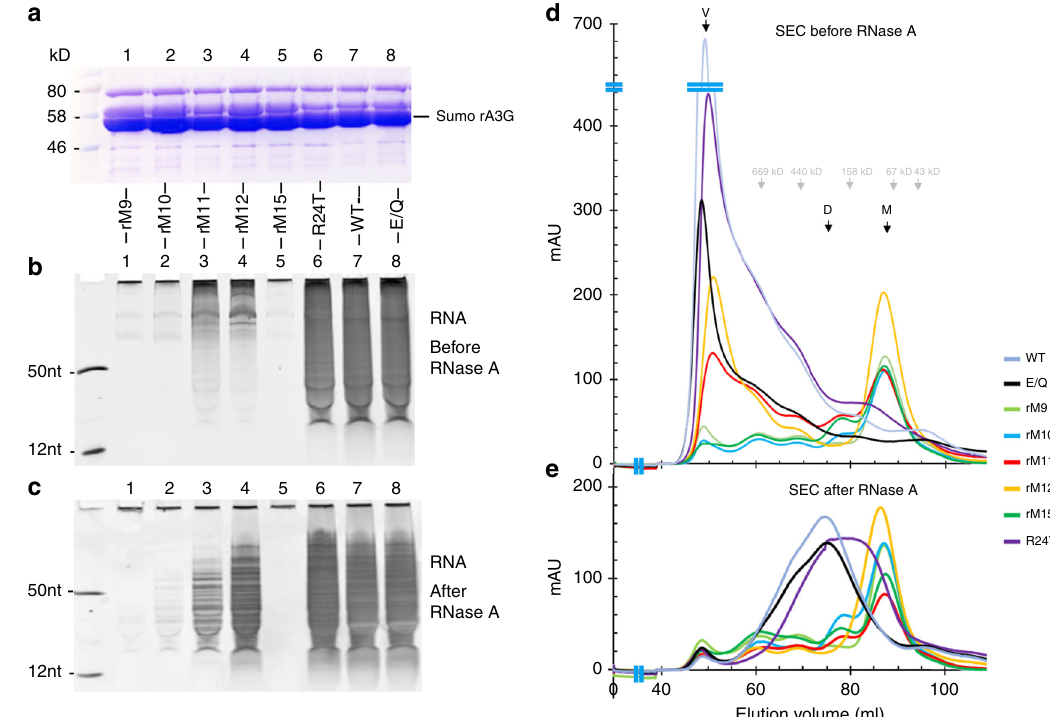
Fig. 3 Probing dimerization and RNA association by targeted mutations of full-length rA3G. a – c The SDS-PAGE protein gel analysis of the His 6 -sumo- rA3G WT and various mutants after nickel af fi nity column puri fi cation ( a ), and 20% denaturing urea polyacrylamide gel analysis of RNAs associated with the proteins without RNase A treatment during puri fi cation ( b ) or with RNase A treatment during puri fi cation ( c ) (see methods for details). d , e Superdex- 200 size exclusion chromatography (SEC) analysis of the sumo-rA3G WT and mutant proteins before ( d ) and after ( e ) RNase A treatment. The positions corresponding to void volume, dimer, and monomer are indicated with arrows. Source data for all panels are provided in the Source Data fi